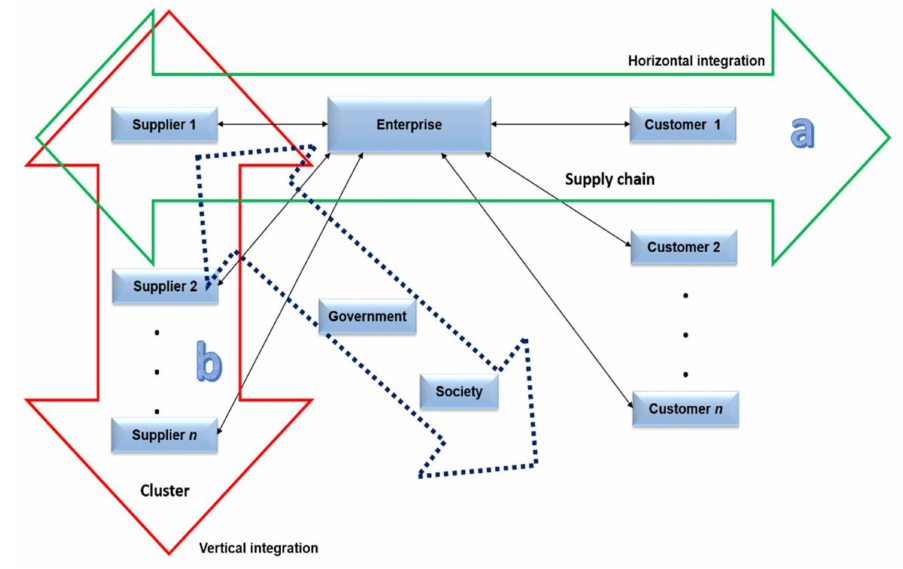
Figure 9. Real supply chain integration in Sahagun City. Source: Author’s